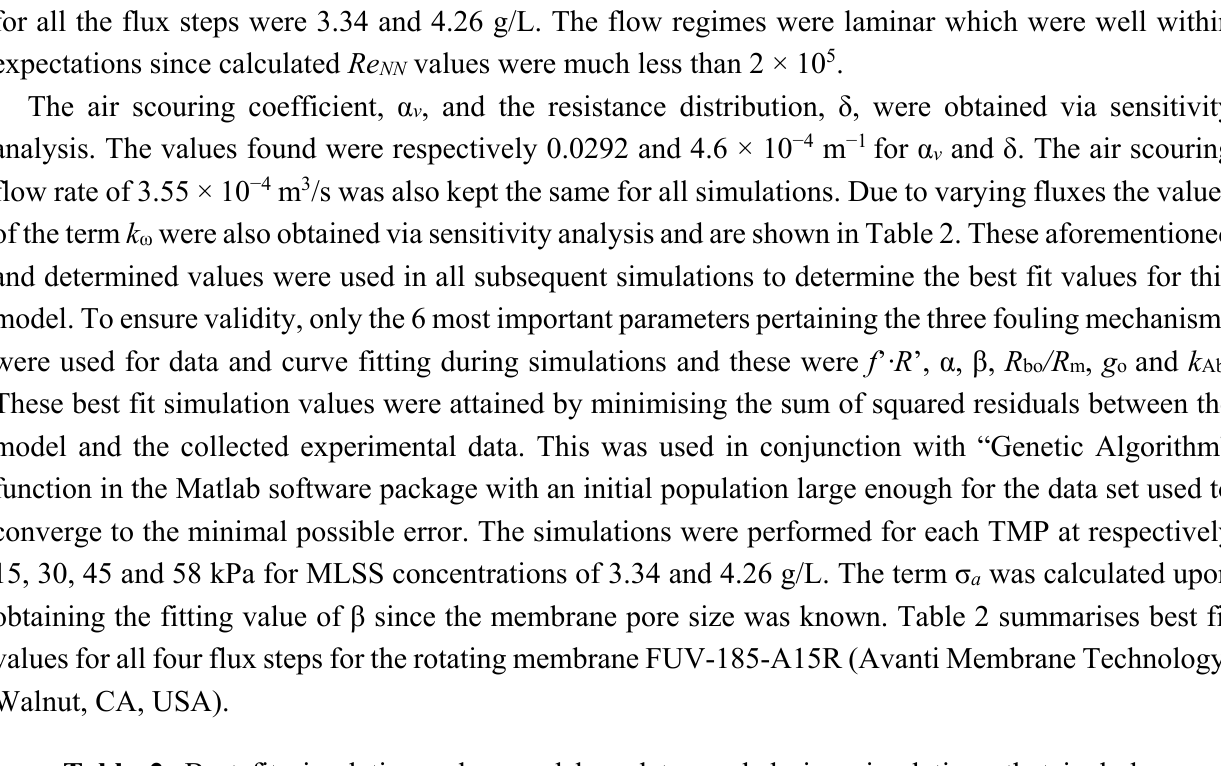
Table 2. Best fit simulation values and key data used during simulations that includes hydrodynamics